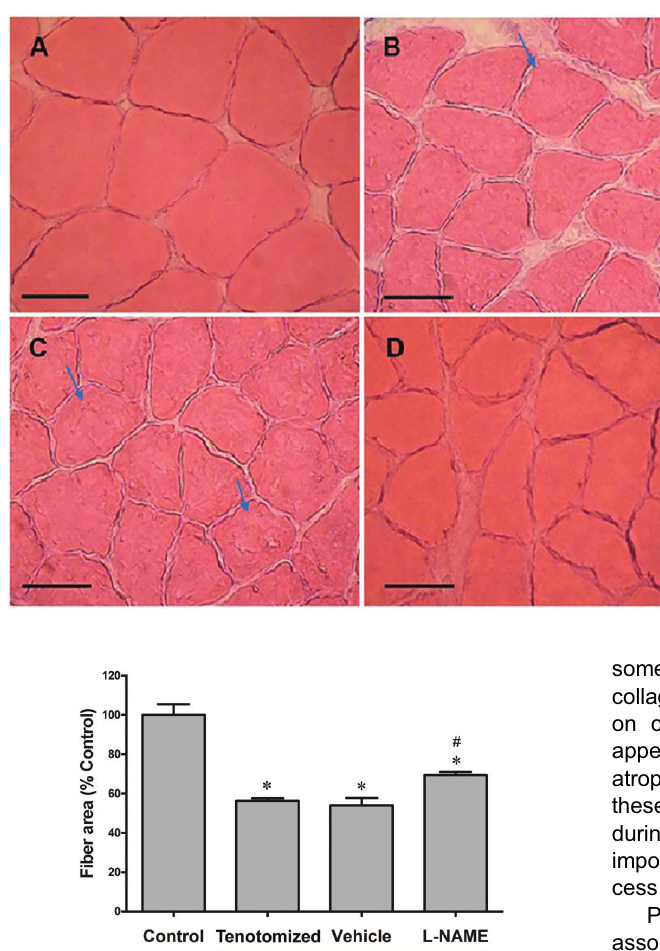
Figure 2. Morphological analysis of muscle fi bers stained with H&E on day 21 post-injury. A , Control; B , tenotomized; C , vehicle, and D , L-NAME. Groups that underwent tenotomy, but no treat- ment with L-NAME ( B , C ) displayed slight mor- phological alterations in muscle fi bers. Arrows show probable CCLs (non-classical morphology). Treatment with L-NAME induced morphological improvement of fi bers ( D ). Scale bar: 200 m m; n X 4 rats/group.